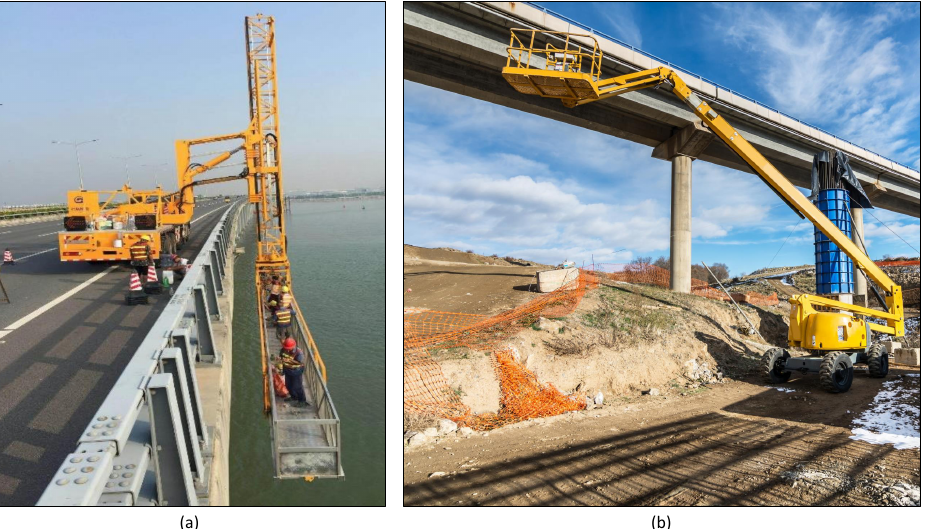
Figure 1. ( a ) Snooper Truck (Source: [5]. Reprinted with permission from Ref. [5]. Copyright 2021 MDPI); ( b ) Man